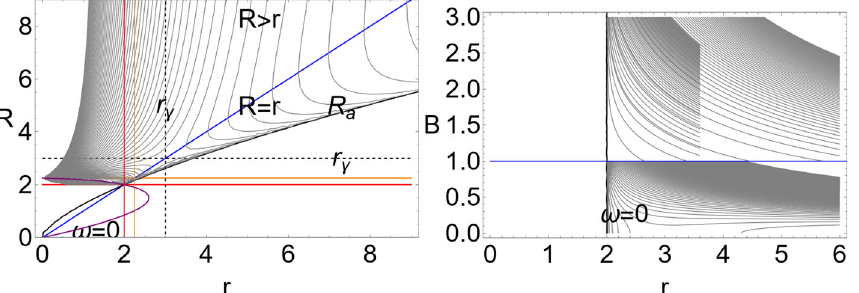
orbit of the Schwarzschild spacetime. The radii r and R at { 2 , 9 / 4 } are also shown. Right panel: Schwarzschild–Melvin solution ( M = 1 ) of Eq. (12). Metric bundles are represented in the plane B − r , where B is the “electro-magnetic” parameter. The value B = 1 is also shown. The horizon corresponds to r = 2 (the mass parameter is M =